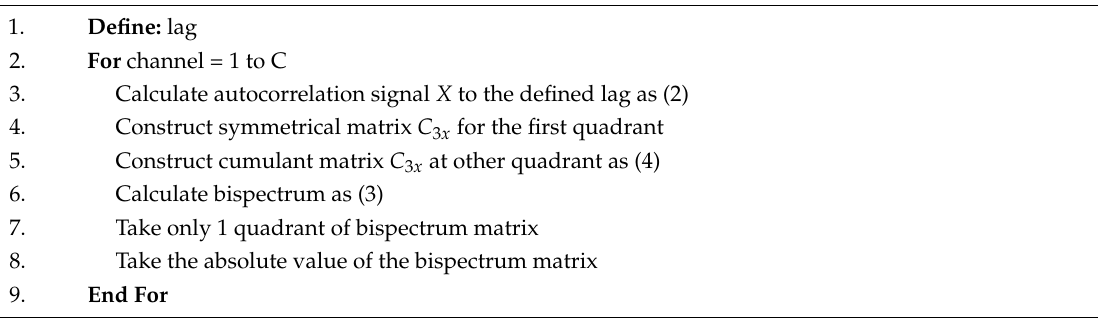
Algorithm 1: Bispectrum calculation in feature extraction